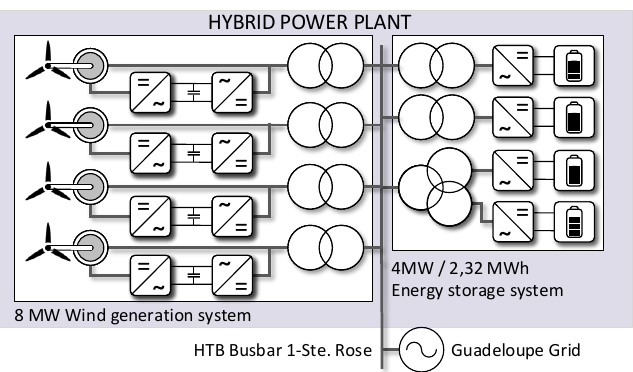
Figure 3. Hybrid power plant diagram: wind farm and battery storage. The hybrid power plant is connected through a point of common coupling located within the Sainte-Rose node, as can be seen in the grid’s PowerFactory model in Figure 4. As shown, the Sainte-Rose node comprises a 63 kV busbar connected to 63 kV/20